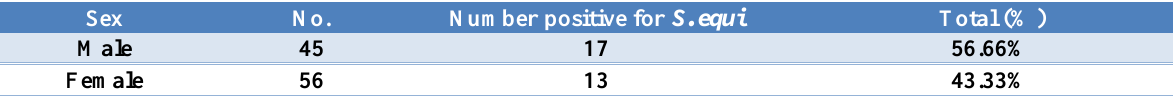
Table, 3: Streptococcus equi isolated from males and females horses.